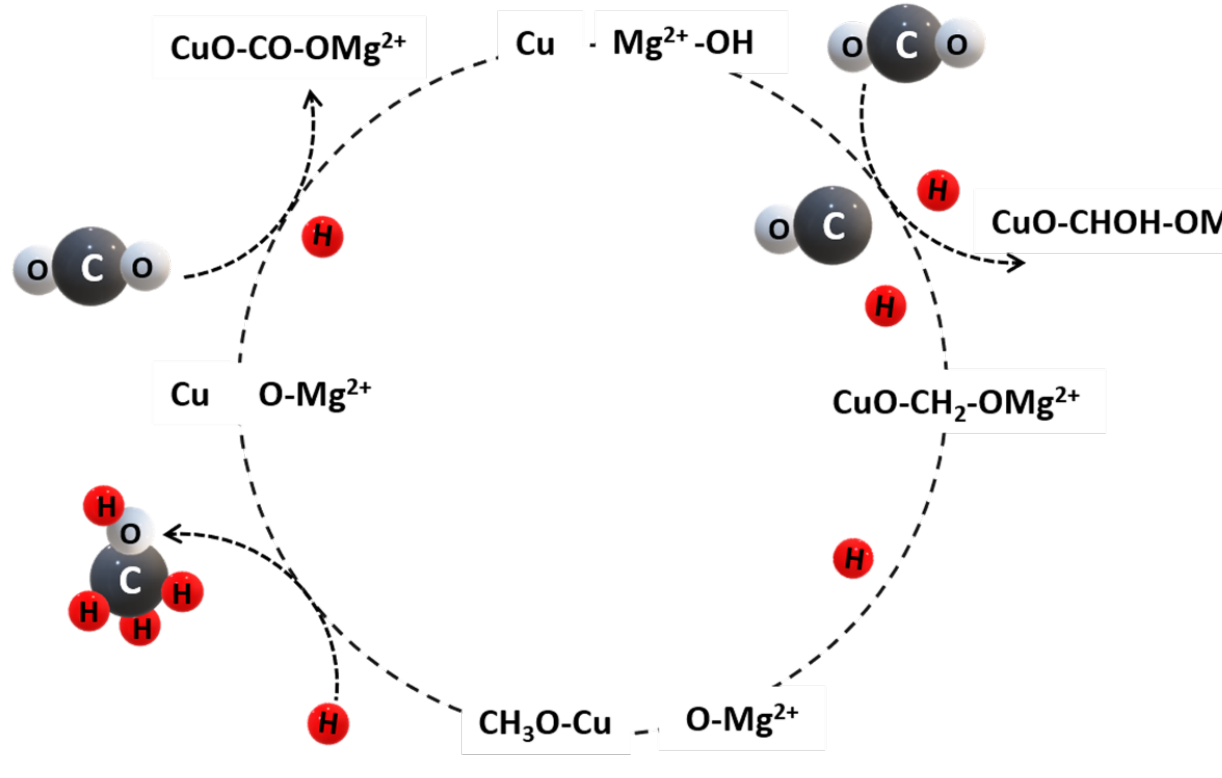
Figure 9. Potential mechanism of methanol synthesis from CO 2 and CO via formate and methoxide over a Cu/MgO catalyst (adapted from [6]).